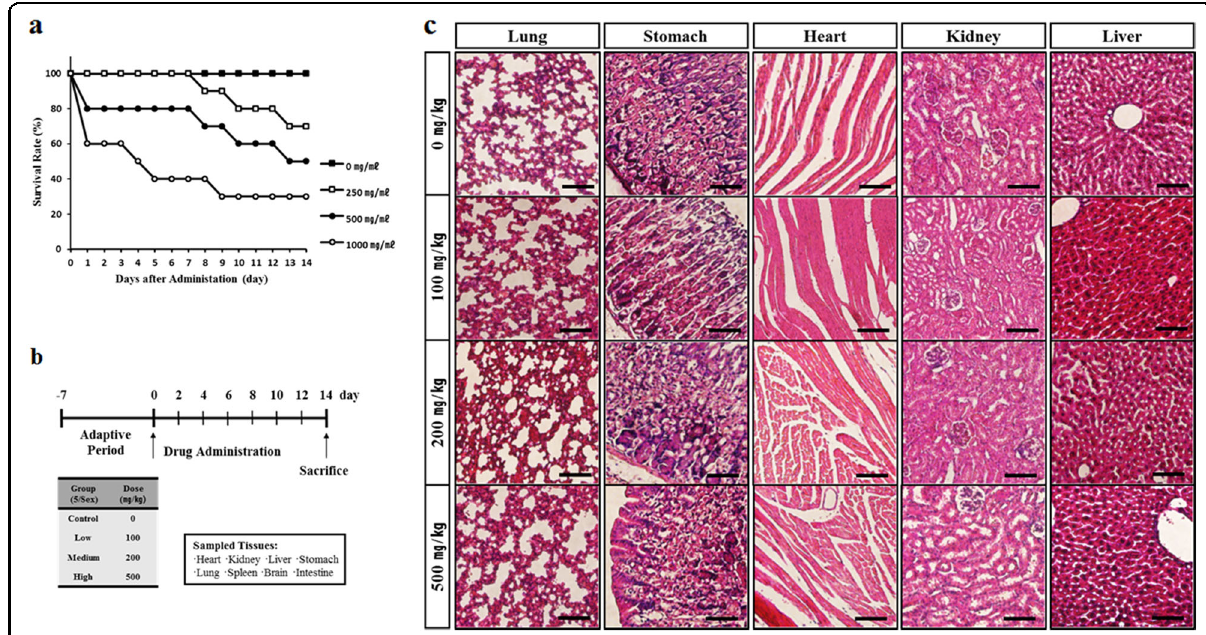
Fig. 3 Single-dose toxicity study. a Preliminary study for dose selection. b Schedule for the single-dose toxicity test. c After 14 days, fi xed organ samples were dehydrated, paraf fi nized, and embedded. Sections of 4 µm were stained with H&E and examined by microscopy. Scale bar, 100 µm